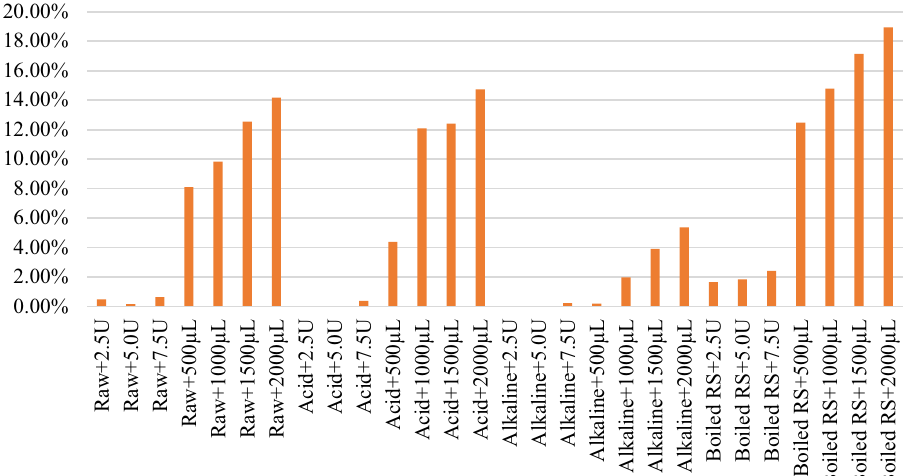
Figure 9. Percentages of Glucose